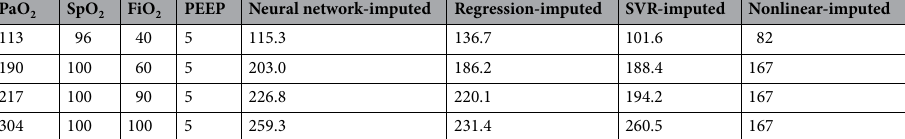
Table 6. Examples of comparing four models applied to four cases from different categories of PaO 2 (< 150, 150–200, 200–300, > 300).